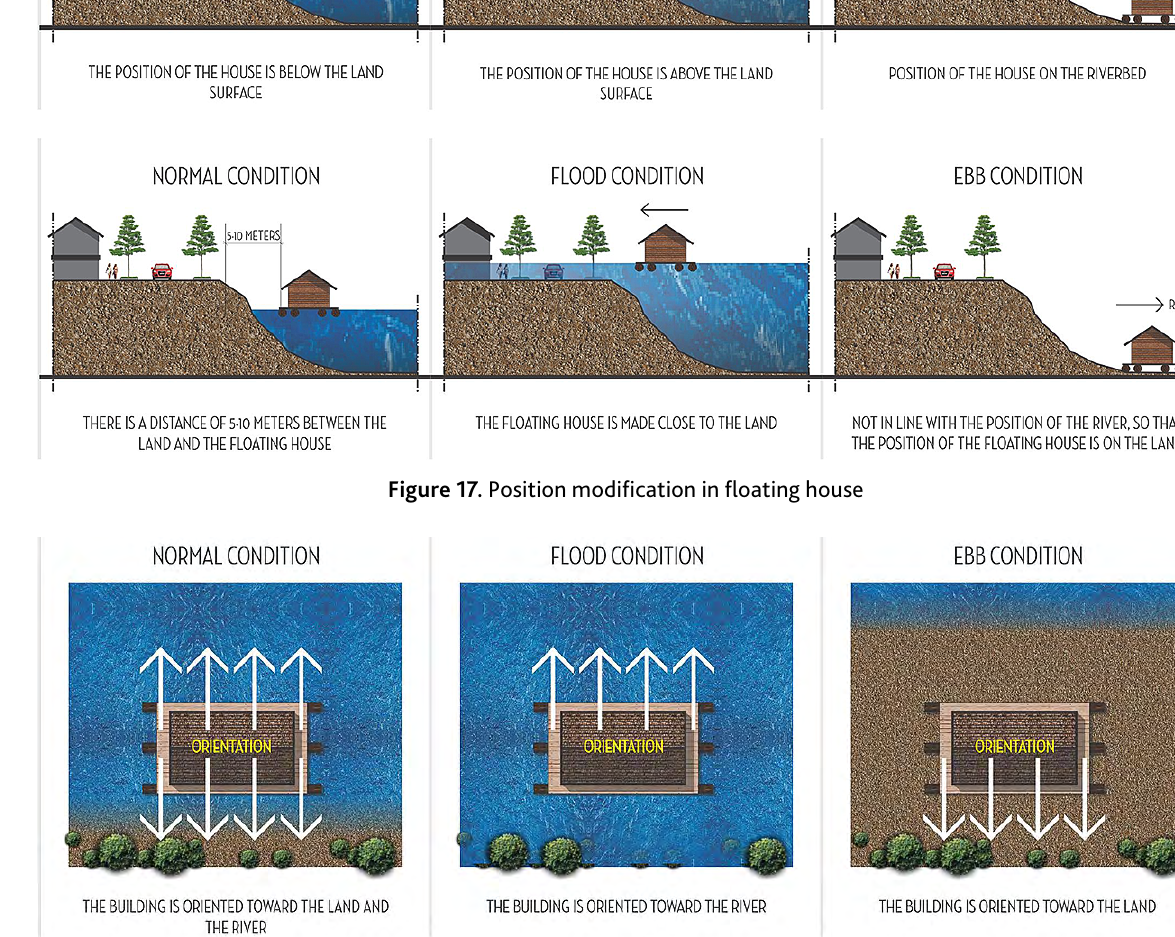
Figure 18. Orientation modification in floating house